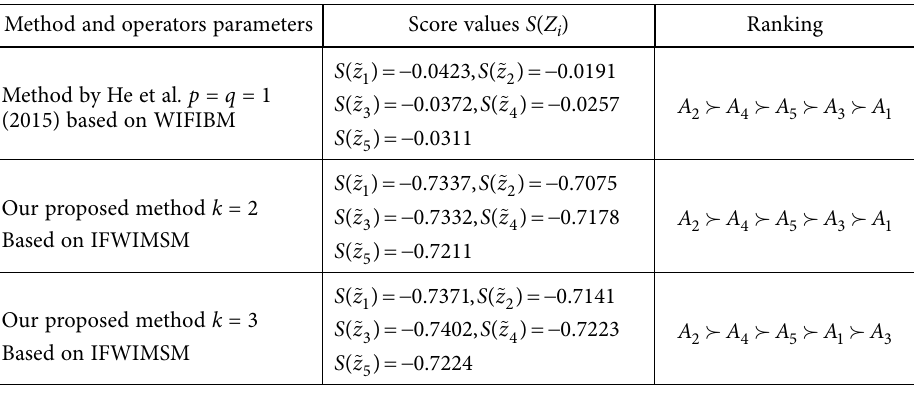
Table 6. Ranking results by different methods and parameters Method and operators parameters Score values S ( Z i ) Ranking 1 Method by He et al . p = q = 1 (2015) based on WIFIBM